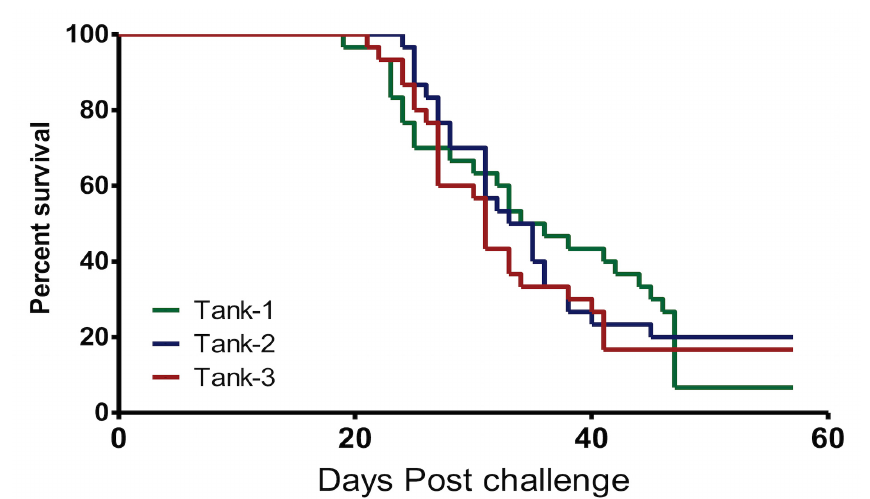
Fig 7. Mortality in non-vaccinated controls. KM survival analysis for comparison of PCSP induced by strain NVI015-TA in the control fish challenged using a three parallel tank system described in Fig 6. Mortality in Tanks 1, 2 and 3 started at 19, 24, and 21 days post challenge, respectively. Overlaps in the KM survival curves for control fish from Tanks 1, 2 and 3 show that there was no statistical difference (p = 0.8223) in PCSPs for the three tanks.